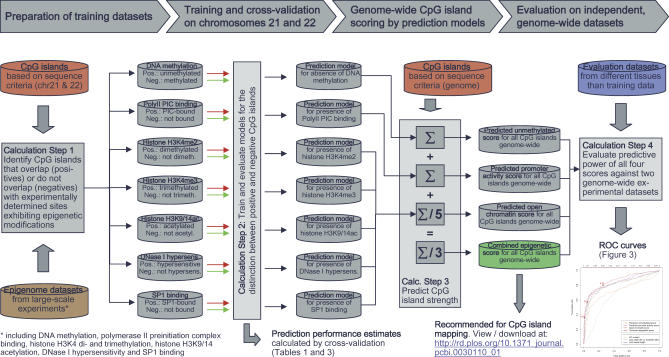
Conceptual OverviewThis figure outlines the workflow used in this study to derive quantitative scores of CpG island strength, and to evaluate their performance as predictors of bona fide CpG islands. The arrows at the top describe the phases of the analysis, the cylinders correspond to input datasets (orange, blue, and brown cylinders) and results datasets (grey and green cylinders), and the rectangular boxes represent major computational steps. The sigmas in the calculation step 3 box stand for summation over the input. The figure is slightly simplified and focuses on a single CpG island map. In fact, the entire workflow was performed separately for three CpG island maps that differ in the repeat-exclusion strategy used (TJU, GGF, and GGM), with subsequent benchmarking of their performances (Figure 5).